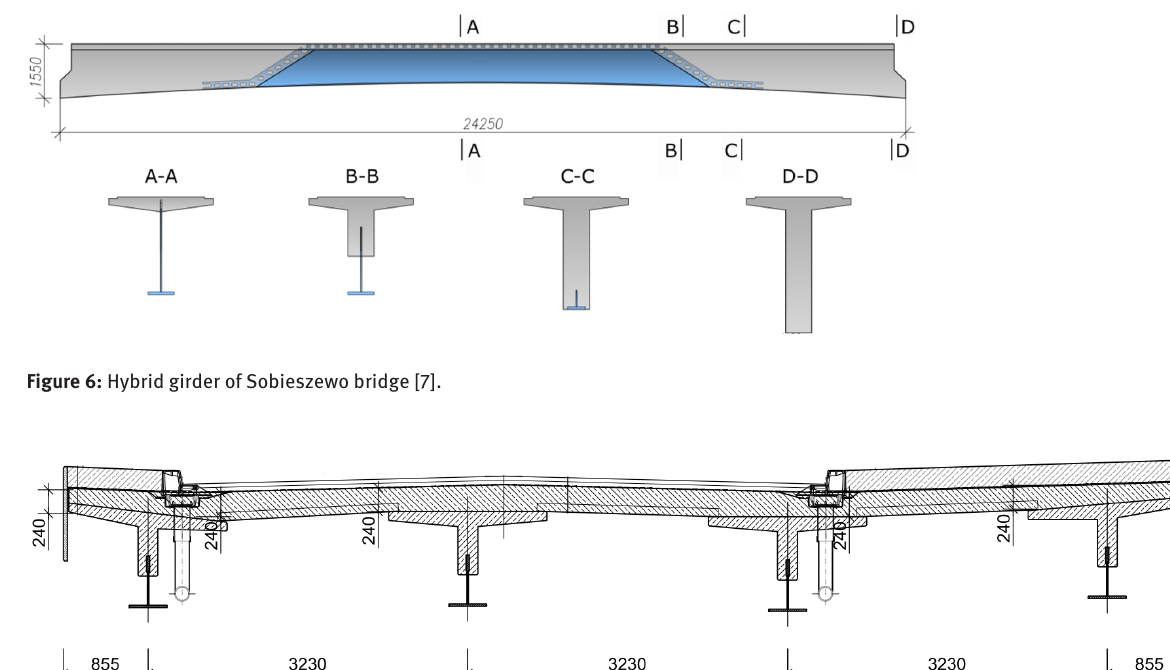
Figure 5: Hybrid beams of Sobieszewo bridge [4, 6].